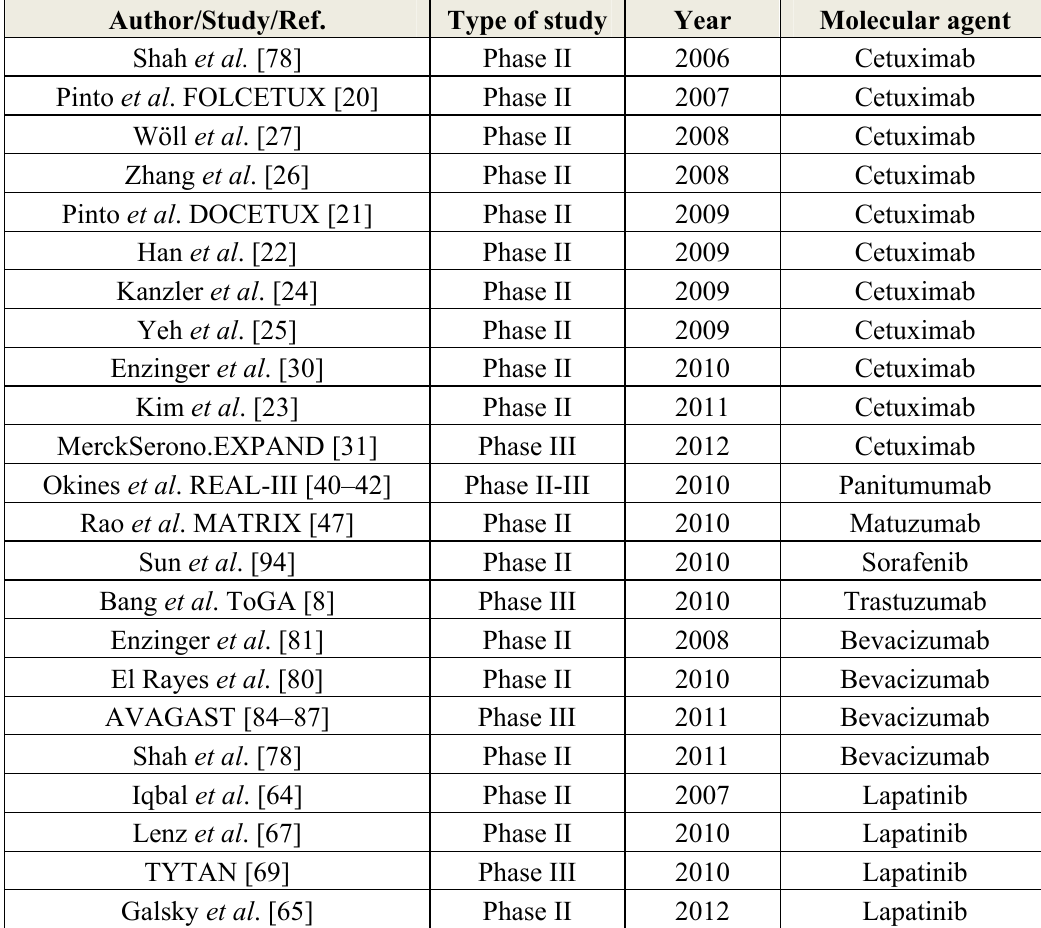
Table A1. Summary of clinical